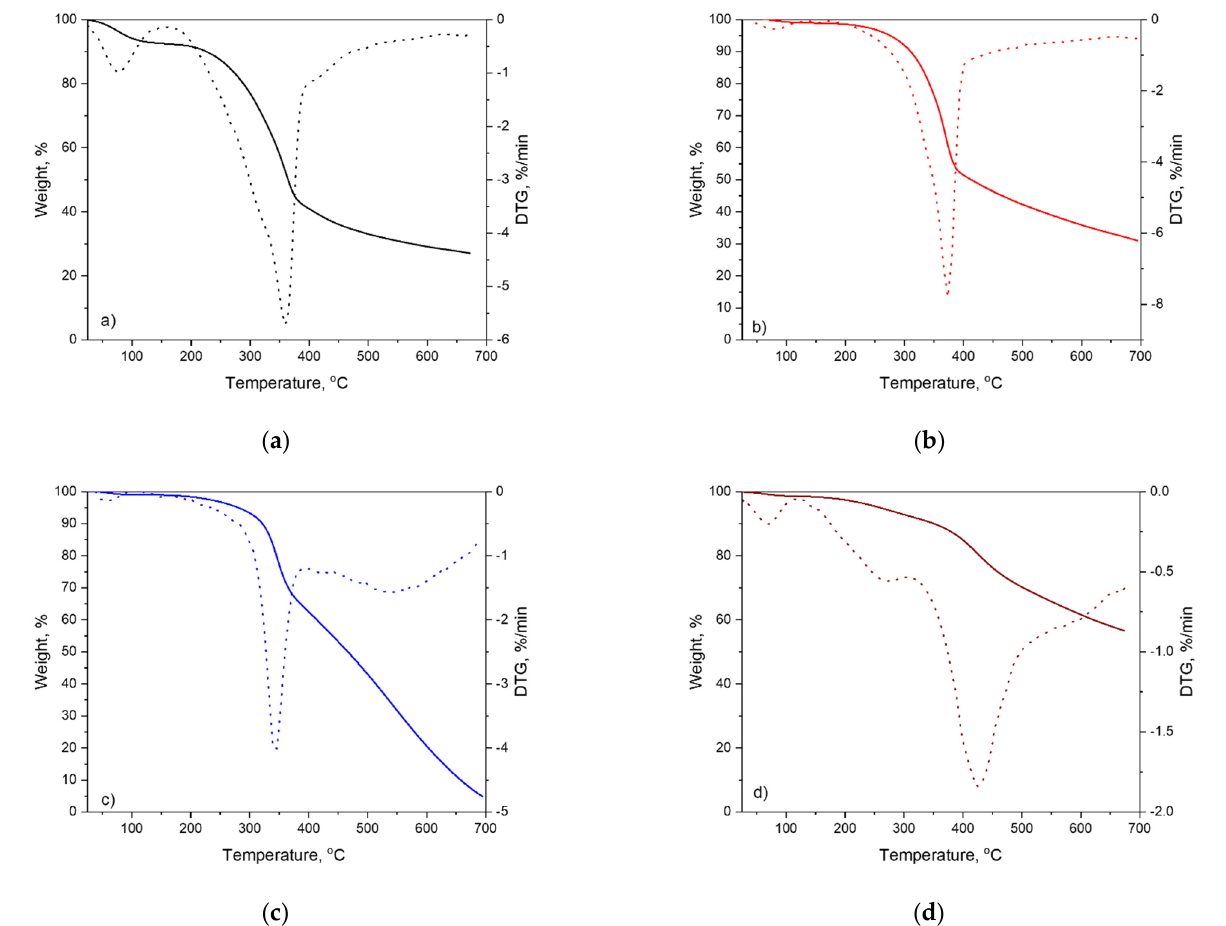
Figure 8. Thermogravimetric (TG) and corresponding derivate thermograms (DTG) for ( a ) SB, ( b ) HC - 200, ( c ) HC - 240, and ( d ) HC - 280.